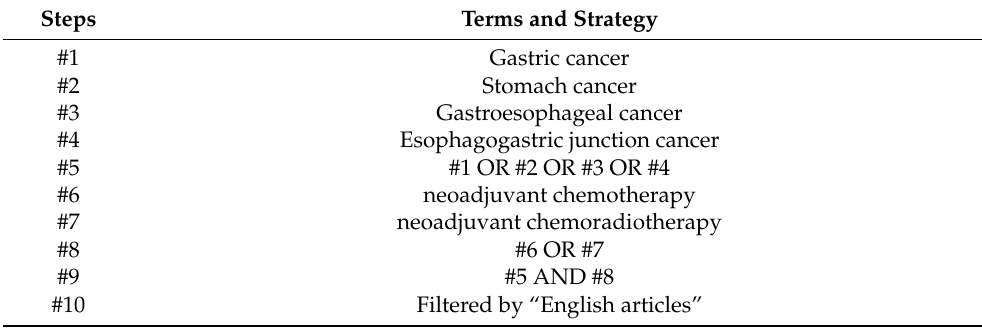
Table A1. The search strategy by advanced search on PubMed and other